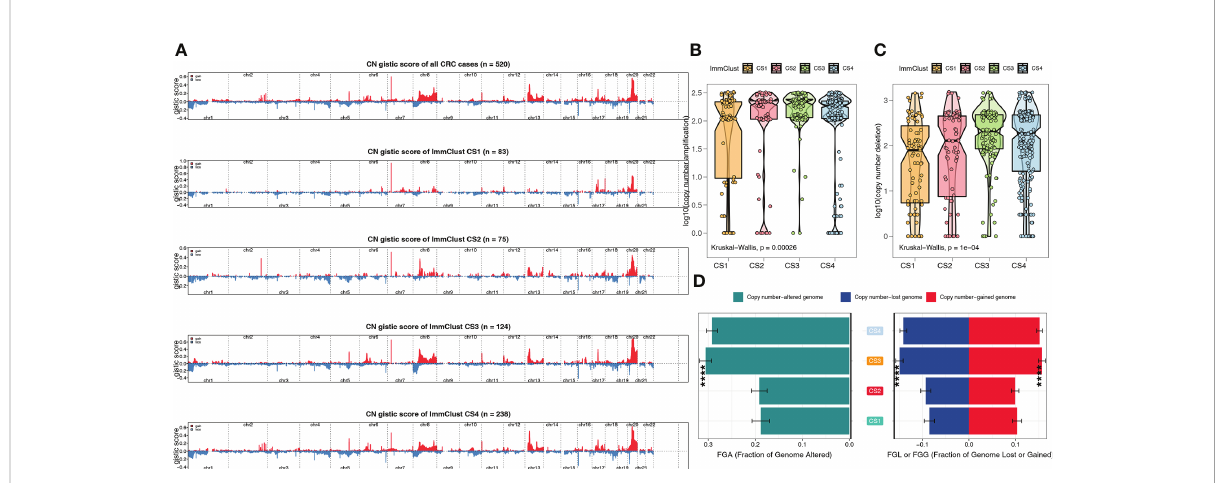
FIGURE 6 The chromosomal instability of the four ImmClusts. (A) Manhattan plot showing the CNV at the chromosomal level. (B) Copy number ampli fi cation of the four ImmClusts. (C) Copy number deletion of the four ImmClusts. (D) Fraction genome-altered scores of the four ImmClusts. ****p < 0.001.